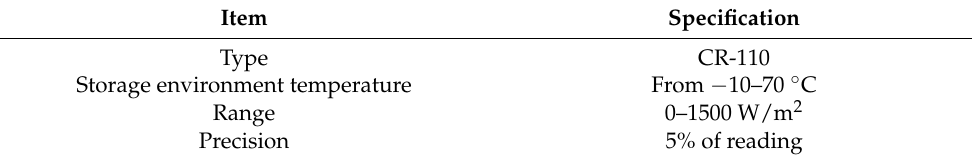
Table 3. Specification of solar radiation meter.